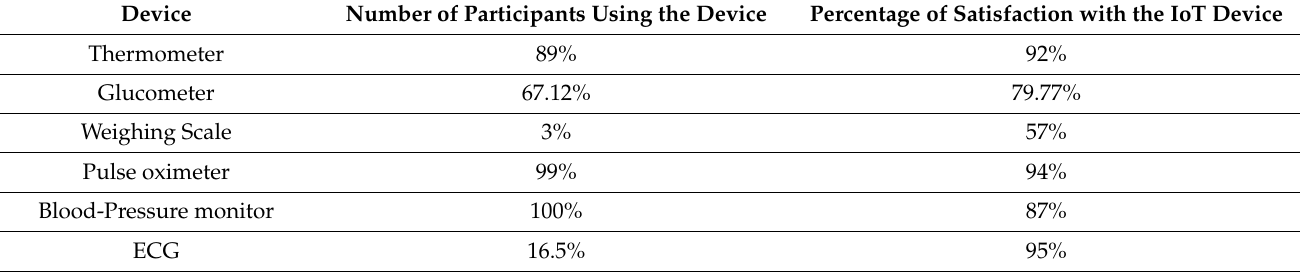
Table 9. Average Results of Using IoT Devices.